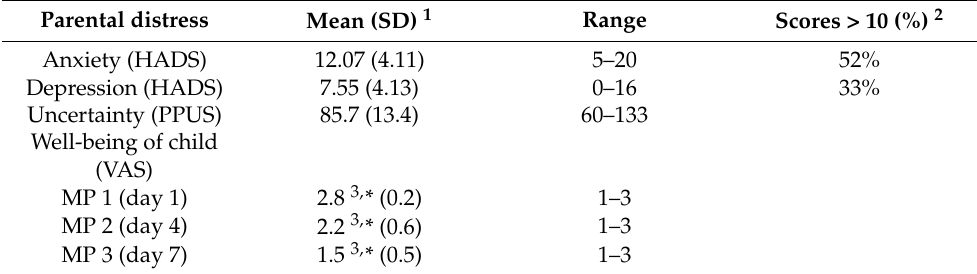
Figure 2. Behavioral observation analysis: ( A ) distance between parent and child; ( B ) used space for interaction; ( C ) used possibilities for withdrawal. Table 2. Measures of parental distress during child hospitalization (N =